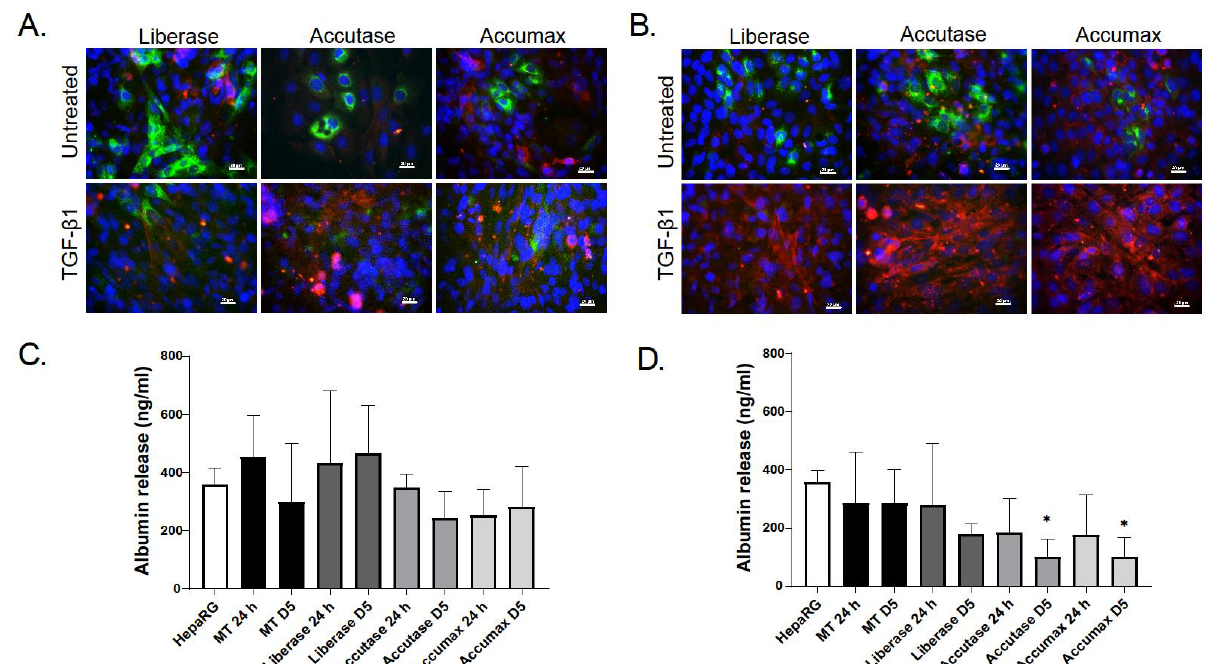
Figure 3. Cellular characteristics and functionality of cells obtained by dissociation of MTs. MTs were dissociated at day 3 ( A ) or 9 ( B ) using Accutase, Liberase or Accumax. Isolated cells were seeded directly into a 96-well and allowed to attach for 3 days. Replated cells were treated with TGF- β 1 (1 ng/mL) for 48 h. Activation of hTERT-HSCs was determined by α -SMA immunostaining and functionality of HepaRGs by albumin immunostaining. Staining for albumin is in green, α - SMA in red and DAPI in blue. Photomicrographs are taken at 40× magnification scale bar is 20 µm. Albumin secretion of cells dissociated at day 3 ( C ) and day 9 ( D ) was determined 24 h and 5 days after re-plating using an ELISA. Data are expressed as albumin concentration ± SD of n = 6 – 9. Statistical analysis using unpaired s tudent’s t -test comparing dissociated cells to MT for each time point; *: p ≤ 0.05.